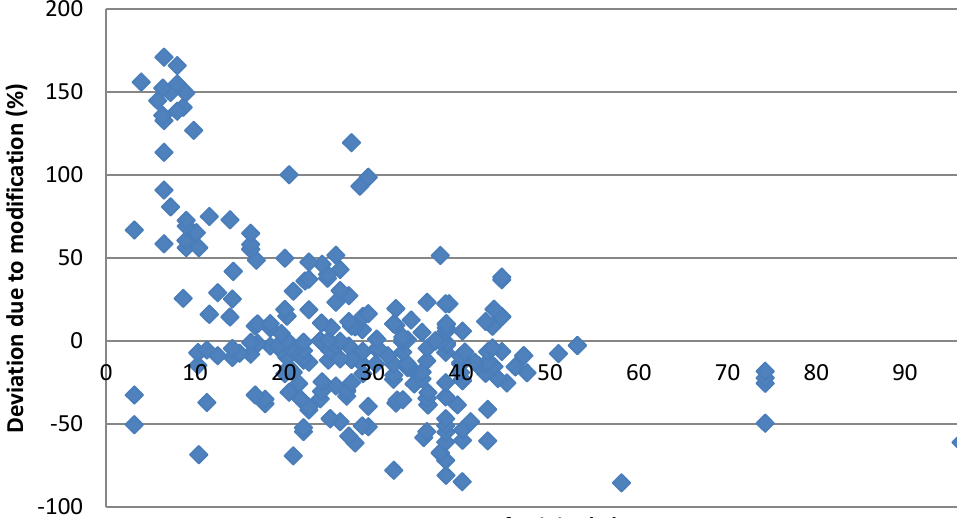
FRES of original Figure 3 Relationship between original FRES and deviation (n=281)